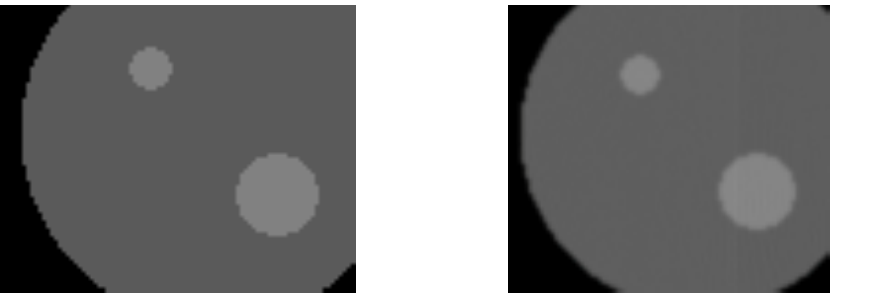
Figure 14. Details of the reconstructed 90th cross-section ( right ) in comparison with its initial shape ( left ).